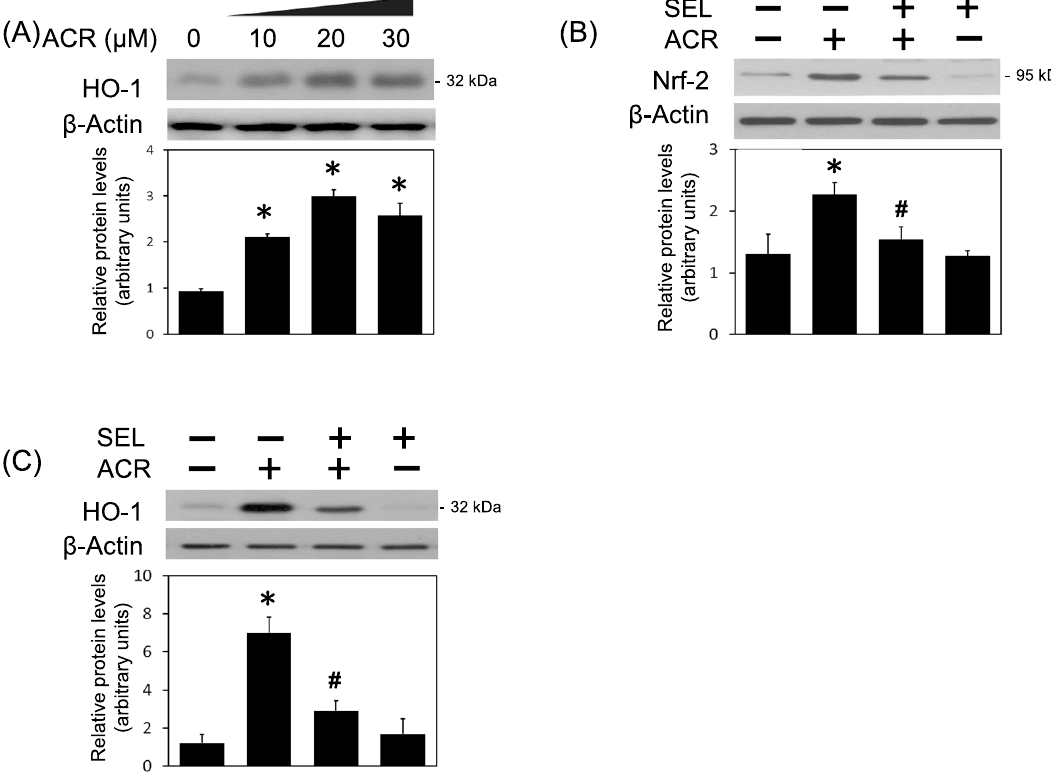
Figure 2. Effect of selumetinib on acrolein-induced oxidative stress. ( A ) Primary cultured cortical neurons were treated with acrolein (0–30 μM). ( B , C ) Primary cultured cortical neurons were treated with acrolein (30 μM) with/without selumetinib (SEL, 10 μM) for 24 h. Western blot assay was employed to measure HO-1 ( A ), Nrf-2 ( B ) and HO-1 ( C ). Each lane contained 30 μg protein for all experiments. Graphs show statistical results from relative optical density of bands on the blots. Values are the mean ± SEM (n = 3/treatment). *p < 0.05 statistically significant in the acrolein groups compared with the control groups; # p < 0.05 statistically significant in acrolein plus SEL group compared with acrolein group by one-way analysis of variance (one-way ANOVA) and followed by the LSD test as post-hoc